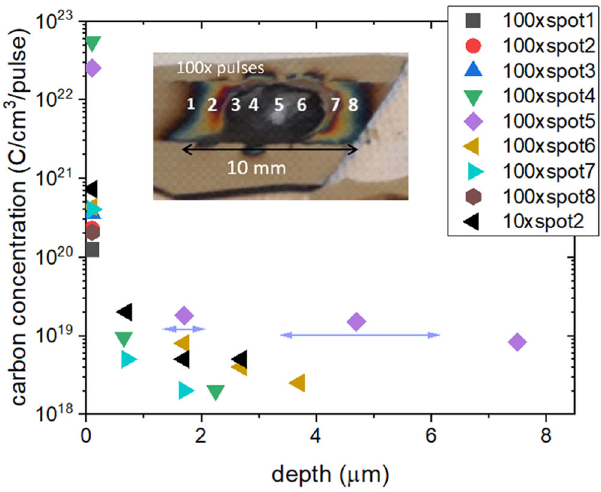
Fig. 5 Nuclear reaction analysis (NRA) of carbon concentrations. Depth pro fi les of carbon for NRA spots on the 100x pulse sample and for the central beam area on the 10x pulse sample ( “ spot 2 ” , Supplementary Note 4). The depth intervals of 1 to 3 μ m used for signal integration are indicated by the arrows. Peak carbon concentrations in spot 4 equal the density of silicon atoms of 5×10 22 atoms cm -3 .